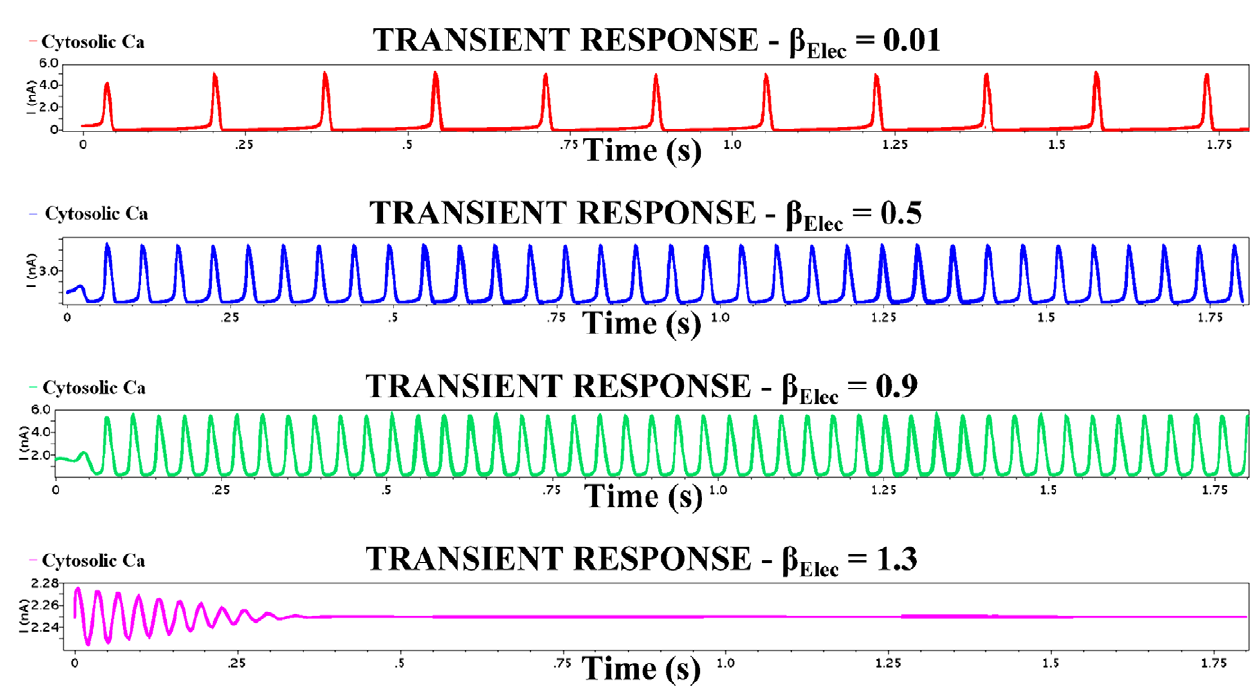
Figure 11. Transient analysis of the m ~ n ~ p ~ 1 intracellular Ca 2 + circuit simulated for the values shown in Table 4 and for four different b Elec values. The electrical parameters are listed in Table 9. The figure illustrates the temporal behaviour of cytosolic Ca 2 z as the value of the parameter b Elec increases. Increasing the value of b Elec , one can observe that the attractor of the system changes from an asymptotically stable limit cycle to an asymptotically stable fixed point. Damped oscillations are generated when the system ‘‘ crosses ’’ the bifurcation point of the system, which takes place when b Elec & 1 .